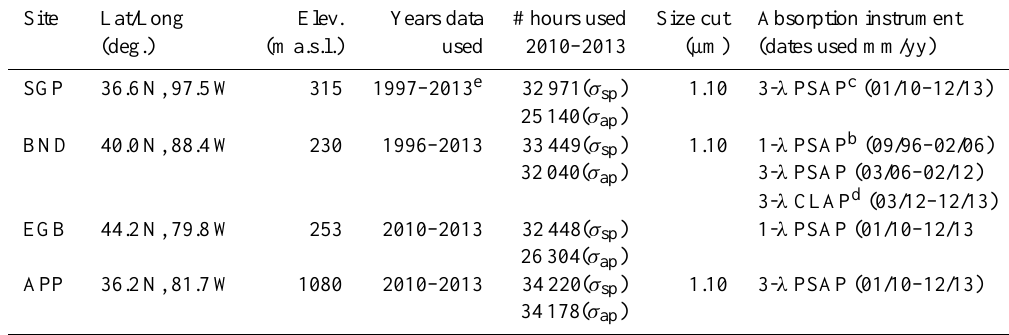
Table 1. Sites, instruments and data period included in the study, listed from west to east. Aerosol sampling size cuts and the instrument used to measure absorption are also included. All sites use a TSI 3563 3- λ nephelometer a to measure total scattering and hemispheric backscattering.